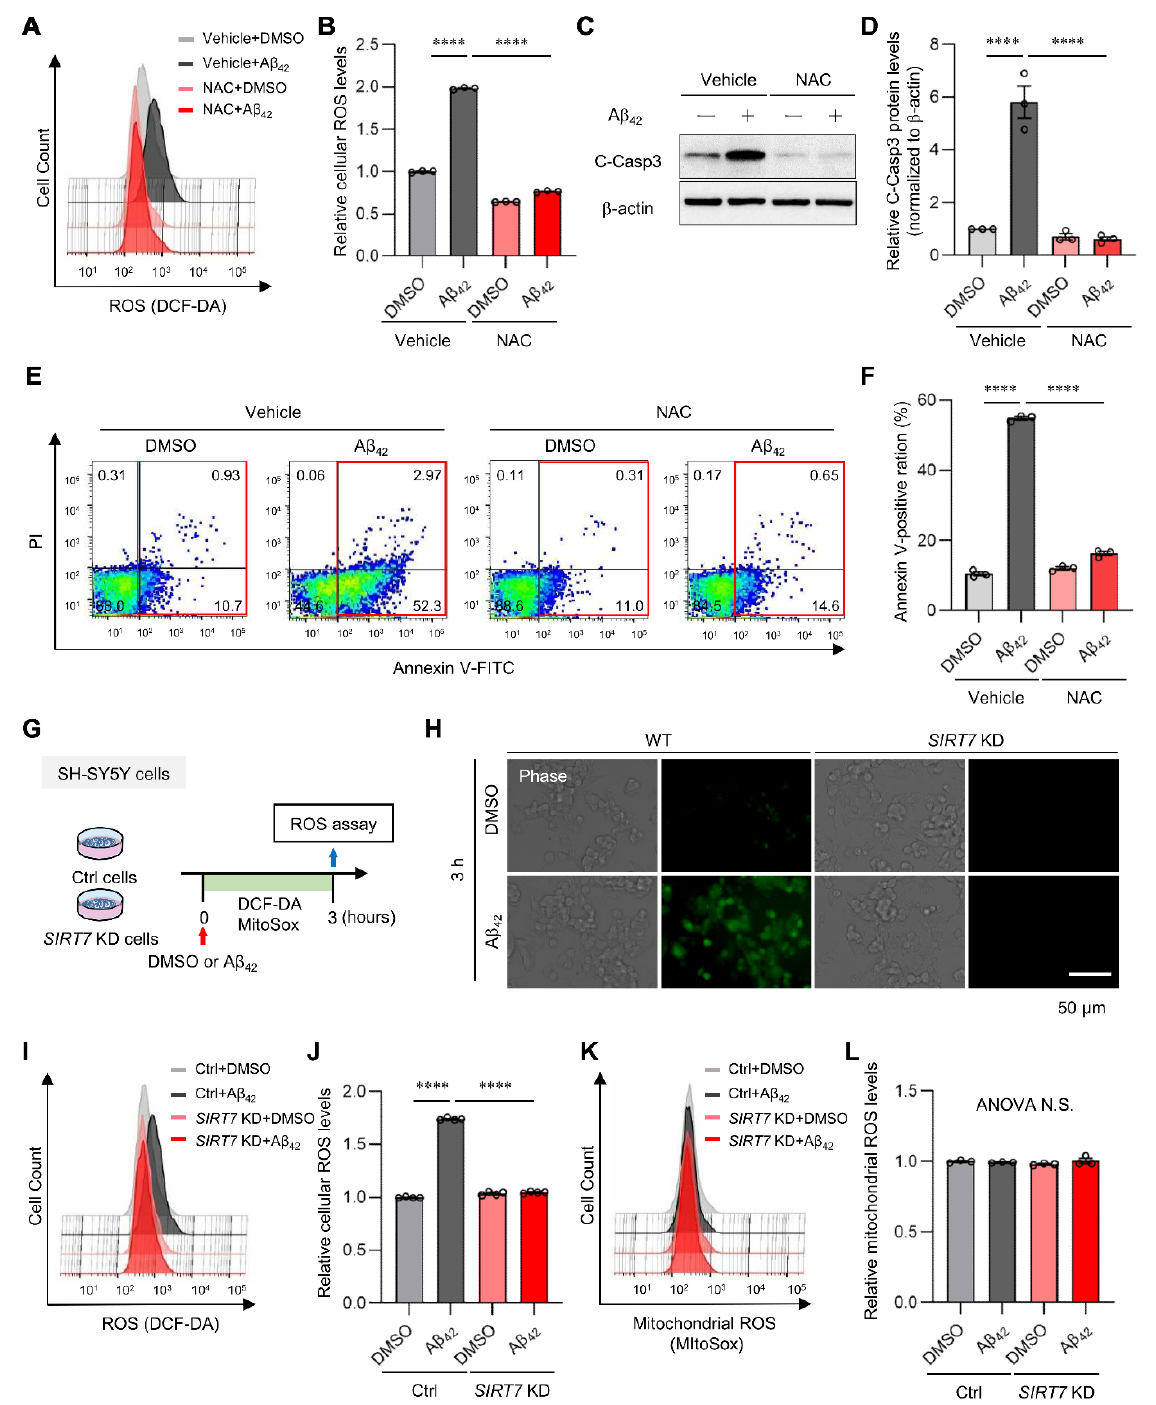
Figure 3. SIRT7 deficiency inhibits Aβ -induced ROS generation. ( A ) Intracellular ROS levels were quantified by flow cytometry after SH-SY5Y cells were loaded with 10 μM CM-H2DCFHDA, pre- treated with 1 mM NAC for 1 h, and then treated with 5 μM Aβ 42 for a further 3 h in the presence of 1 mM NAC. Histogram of DCF-DA intensity of a representative experiment. ( B ) Vertical lines indi- cate the mean fluorescence values with the control cells set as 1. The geometric mean fluorescence intensity (MFI) ± SEM of three independent experiments was analyzed. ( C ) SH-SY5Y cells were pre- treated with 1 mM NAC for 1 h, and then incubated in the presence of 5 μM Aβ 42 and 1 mM NAC for a further 24 h. The intensity of cleaved caspase 3 was determined by Western blot analysis. ( D ) The value of cleaved caspase 3 was normalized to that of β -actin. ( E ) Flow cytometry analysis was performed on cells treated in the same condition as that in Figure 3C. Representative flow cytometry plots using annexin V-FITC/PI staining for apoptosis. ( F ) The percentage of total annexin V-positive